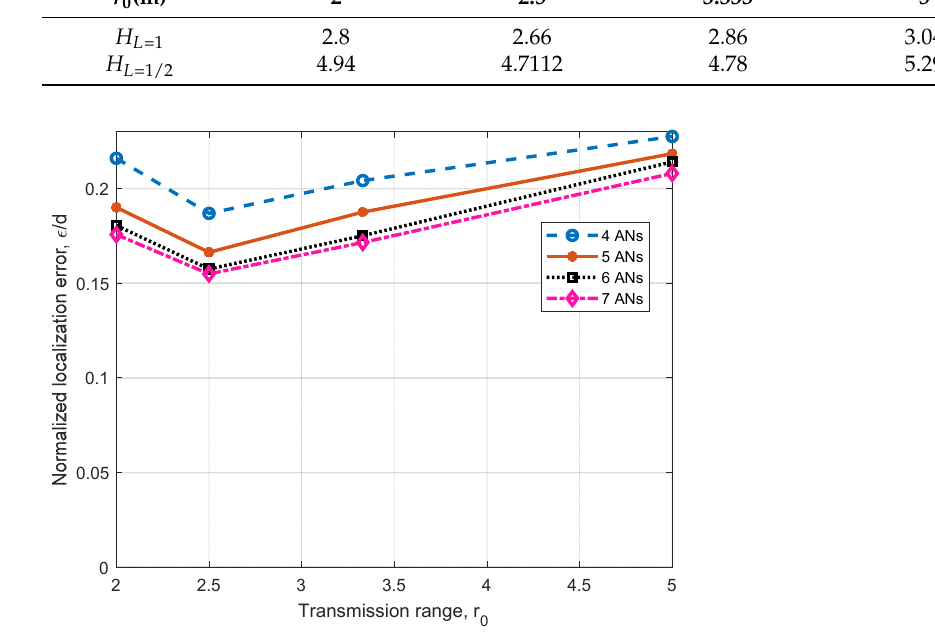
Figure 10. Error ( ε / d ) analysis for different transmission ranges r 0 for four to seven ANs with L = 1.